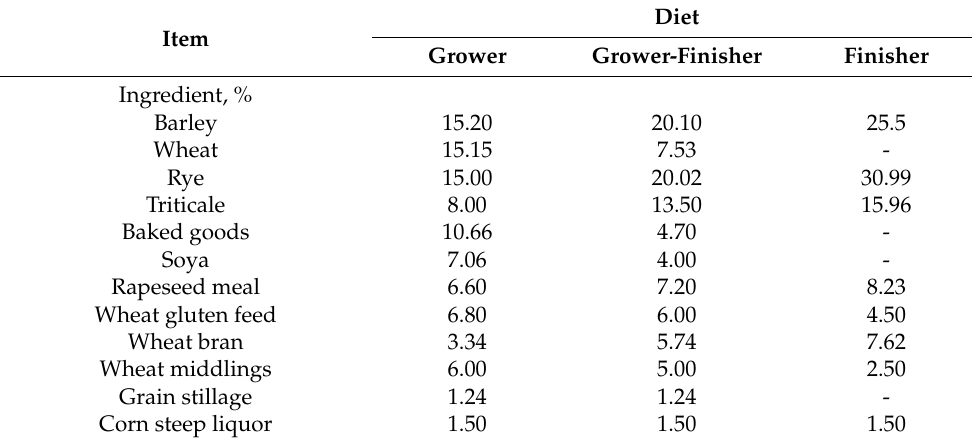
Table 1. Biological and chemical compositions of the compound feeds provided during fattening.